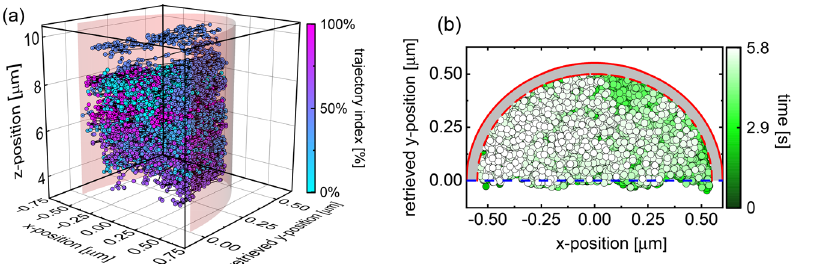
Figure5: Three-dimensional(3D)trackingofa 100 nm gold nanosphere inside the water- fi lled mode graded index fi ber (MGIF). (a) Parts of the 3D trajectory of a single diffusing nanosphere in three spatial di- mensions within the upper part of the microchannel (indicated by the semi- transparent red background). Note that the position retrieval along the y -direction is only valid within the upper semicircle and therefore only this part is presented in